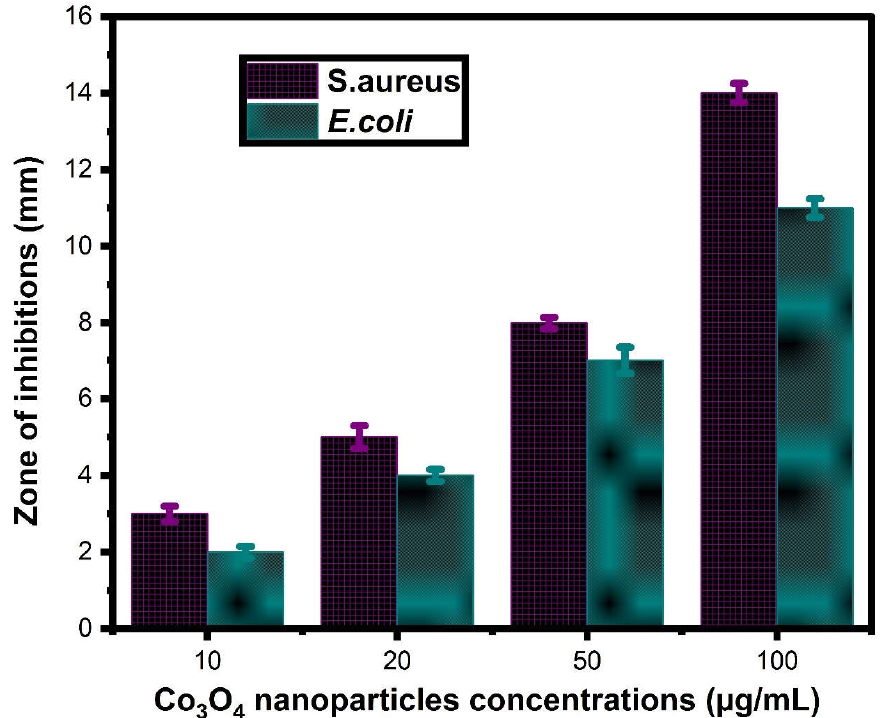
Figure 9. Antibacterial activity of Co 3 O 4 nanoparticles against S. aureus and E. coli with different concentrations.